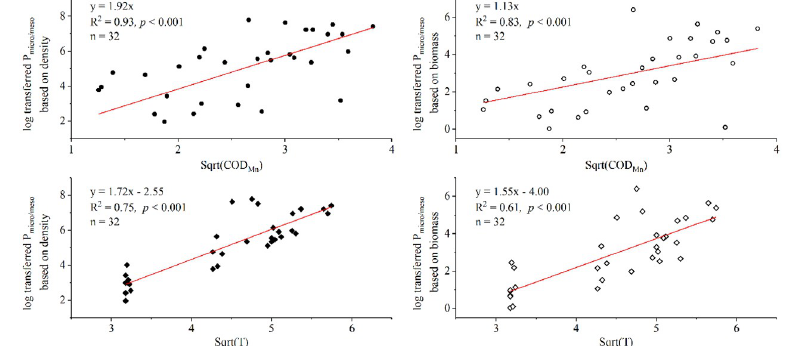
Fig 9. The relationship between zooplankton size and key environmental parameters that were associated with CCA 2. P mico/meso mirrored the portion of microzooplankton to mesozooplankton based on density and biomass data. P mico/meso were log transferred, and environmental parameters (COD Mn and T) were sqrt transferred. Four samples were excluded because the denominators of the ratios were